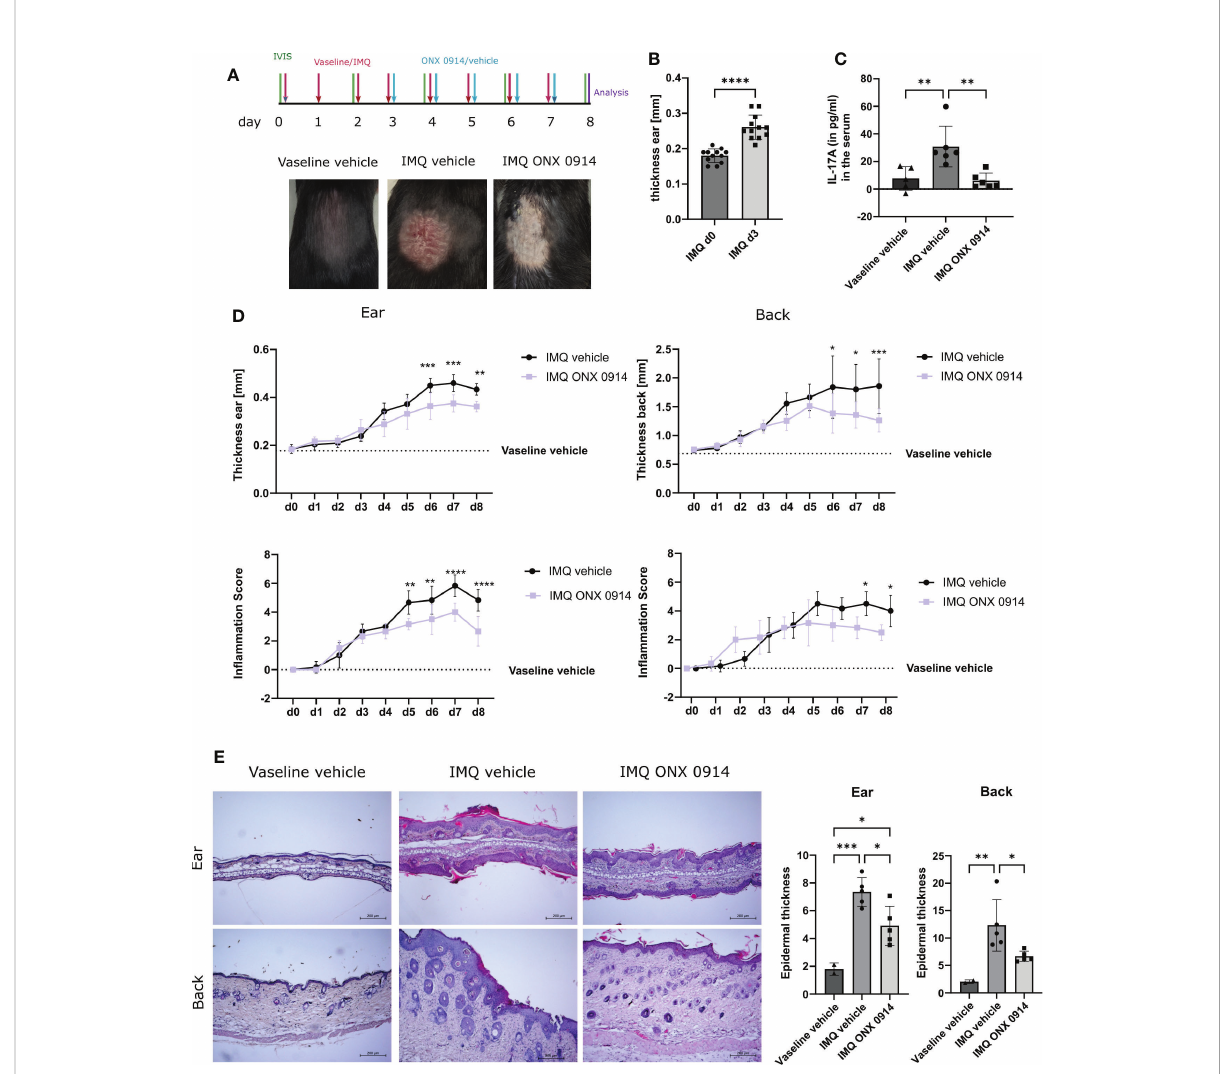
FIGURE 5 Immunoproteasome inhibition ameliorates IMQ-induced psoriasis-like in fl ammation in mice. IL-17A-GFP mice were treated with IMQ or vehicle (vaseline) on the back and the ear for 8 consecutive days. (A) Experimental setup and representative images of the back of the mice after 8 days of IMQ application. (B) Ear thickness in mm on day 0 and day 3 of IMQ-treated mice (n = 12). Data were pooled from three independent experiments and analyzed by paired t-test. (C) IL-17A levels in the serum of mice after 8 days of treatment. Data (vaseline vehicle-treated mice n = 5, IMQ vehicle and IMQ ONX 0914 n = 6) was pooled from two independent experiments and analyzed by one-way ANOVA followed by a Tukey´s test (D) Ear and back thickness were measured with a thickness gauge. On the g -axis, the ear thickness in mm is depicted. The thickness from the vaseline vehicle group is depicted for clari fi cation (dotted line) and was not statistically analyzed. The in fl ammation score was measured visually on alternate days and results from the sum of the eczema and scaling scores, which is shown on the g -axis. Data (IMQ vehicle n = 6, IMQ ONX 0914 n = 6) was pooled from two independent experiments and analyzed by a two-way ANOVA followed by a S ̌ ida ́ k test. (E) Representative images of hematoxylin-eosin stained sections from the ear and back of vaseline-vehicle, IMQ-vehicle, or IMQ-ONX 0914-treated mice. The scale bar is 200 m m. Epidermal thickness from the ear and the back was calculated using ImageJ. Data (vaseline vehicle n = 2, IMQ vehicle, and ONX 0914 n = 5) was pooled from two independent experiments and analyzed by one-way ANOVA followed by a Tukey´s test. All values represent mean ± SD. * p < 0.05, ** p <0.01, *** p < 0.001, and **** p <